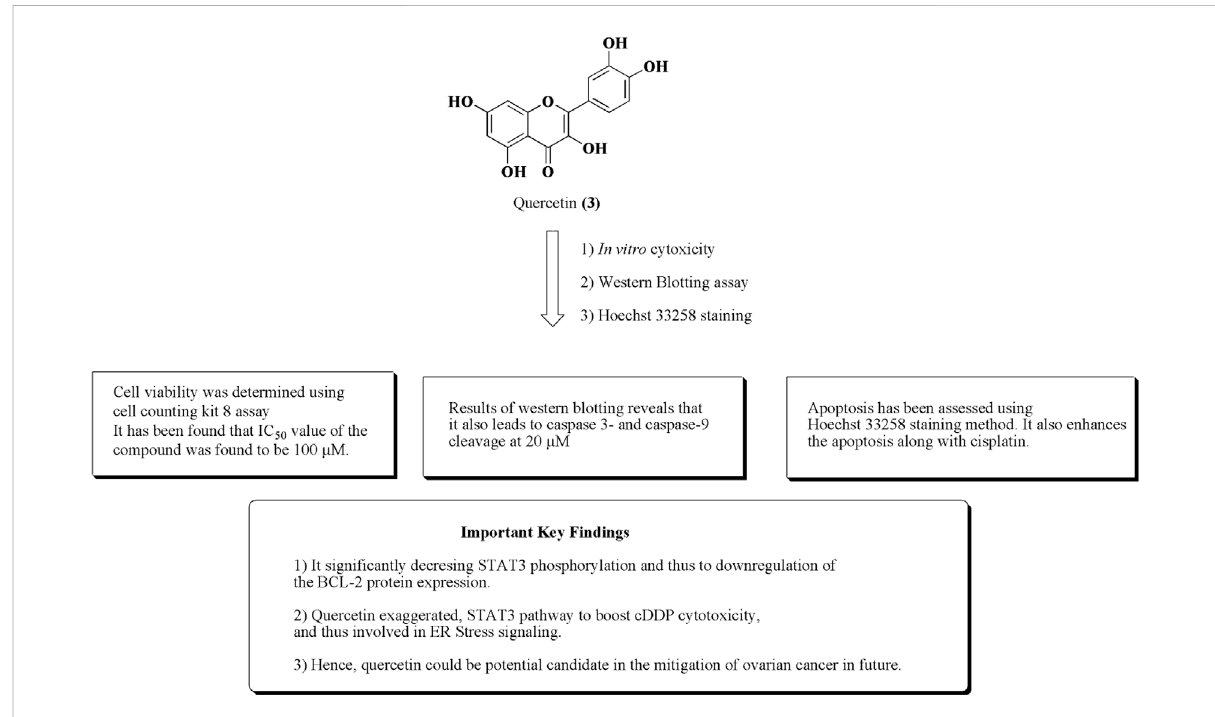
FIGURE 6 Structure of quercetin along with important key fi ndings. Anti-ovarian cancer potential of quercetin was assessed by in vitro cytotoxicity, Western blotting assay, and Hoechst 33258